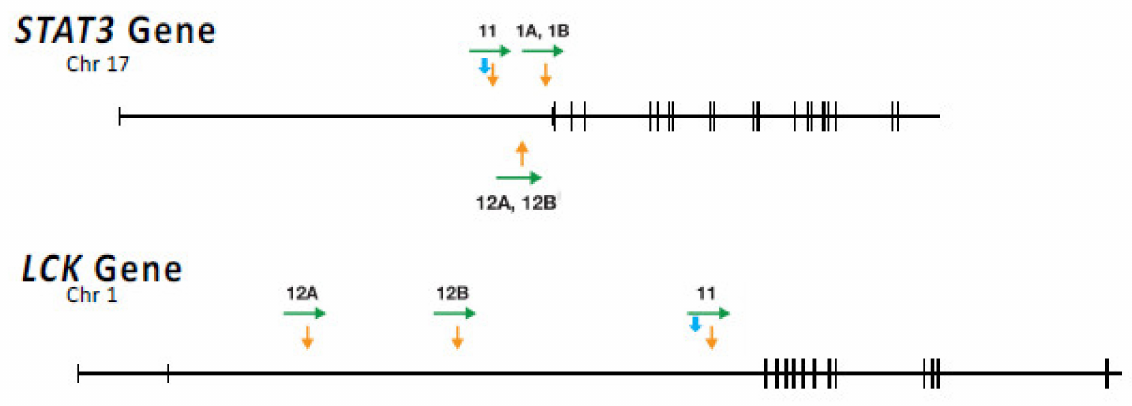
Figure 9. Locations of proviruses in T cell lymphomas. The orange arrows show the location of HIV proviruses in tumors from 3 different individuals (numbers 1, 11, and 12), with tumors obtained from different sites denoted as A and B [59]. The green arrows indicate the orientation of the integrated provirus. The transcribed portion of each gene is shown by the horizontal line, with short vertical lines denoting exons. The light blue arrow indicates the translational start site. Note that, in the case of lymphoma 12, both tumors had a provirus at exactly the same site in STAT3 , but, although both tumors had a provirus in in LCK , the proviruses were in different sites. This pattern indicates that STAT3 integration was followed by growth and spread of the tumor, which must have occurred before the two independent integrations into LCK. From